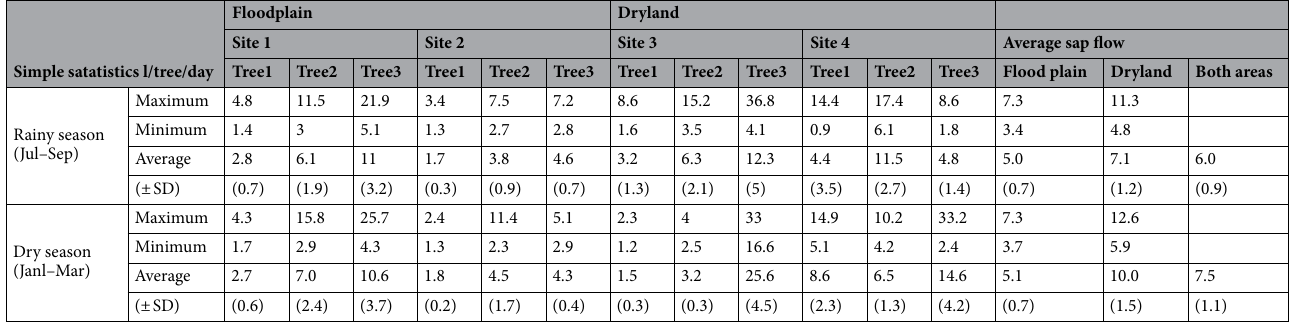
Table 2. Water use of Prosopis trees in floodplains and drylands during the dry and the rainy seasons.